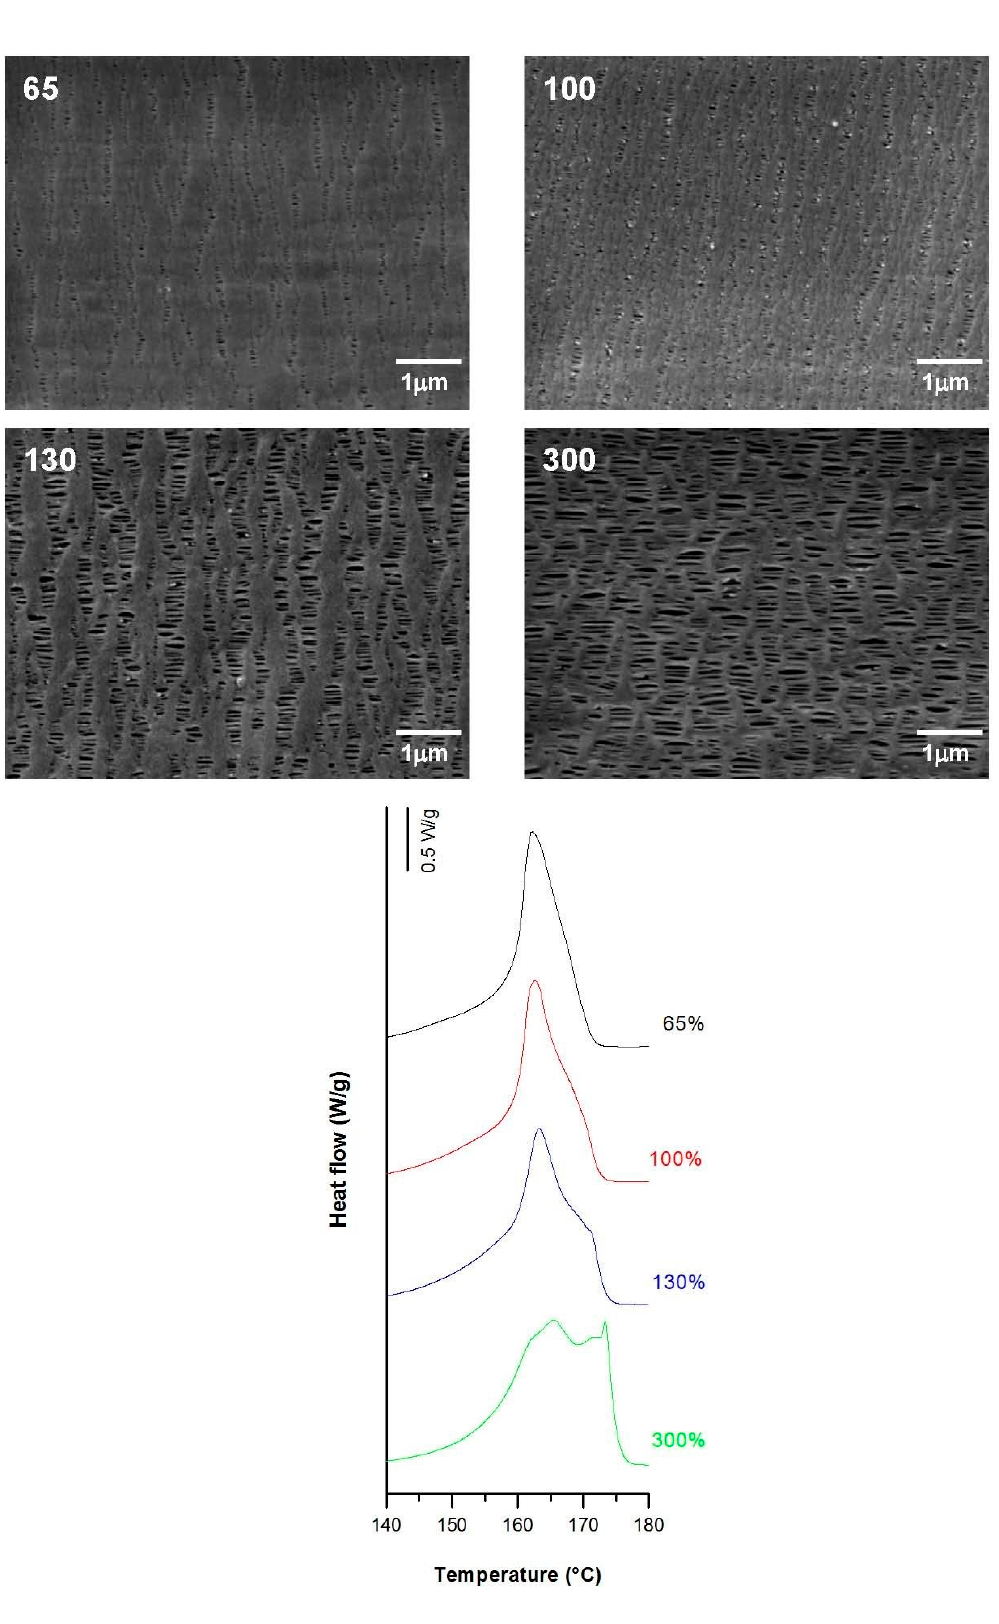
Figure 12. Influence of hot strain extent. Common uniaxial strain conditions. Cold stage 0.3 mm/min, 20%; hot stage, 0.3